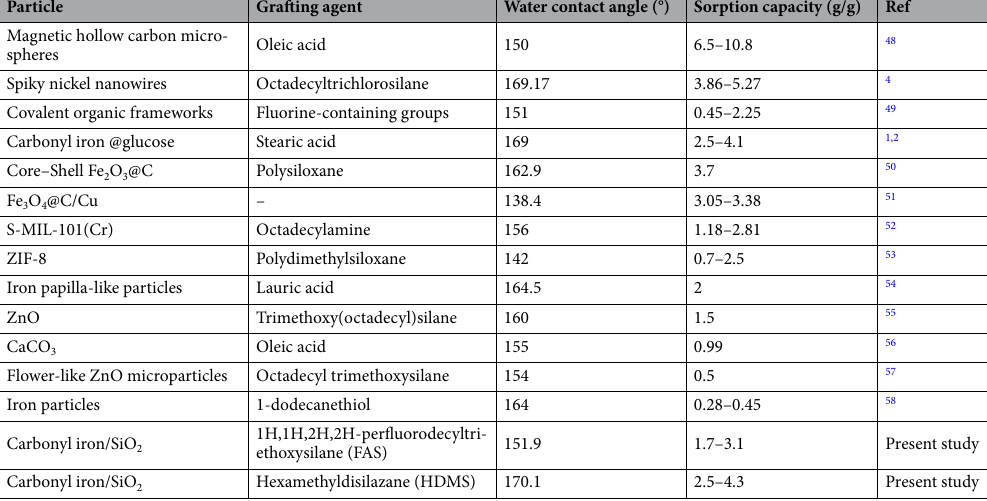
Table 2. Sorption capacity of various